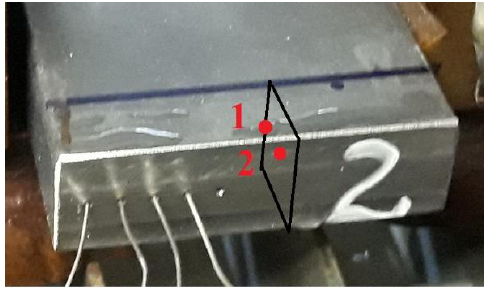
Figure 1. A specimen (i.e., Specimen No 2) with holes to measure temperature with thermocouples.